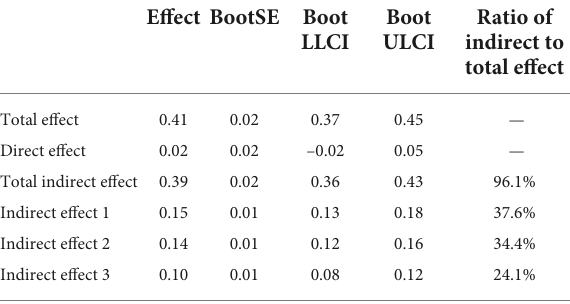
FIGURE1 The chained mediation model ( n = 1971). ∗∗∗ p < 0.001.